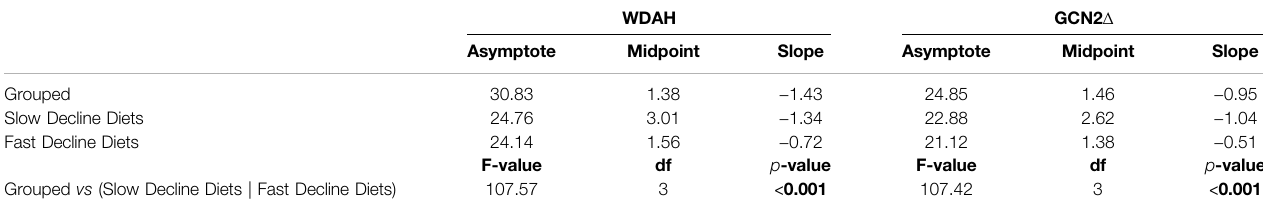
P-values in bold indicate signi fi cant differences in model fi